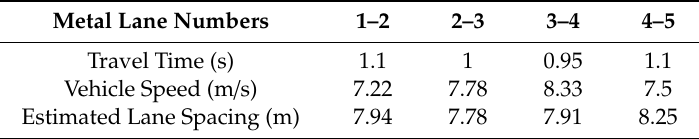
Table 1. Metal lane spacing estimation for Scenario 2.